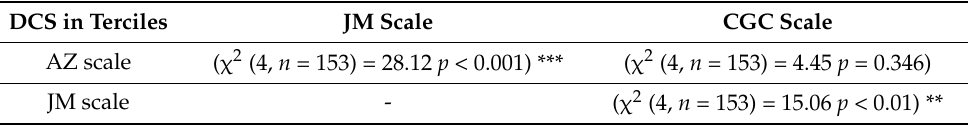
Table 6. Percentage of the sample in the same terciles [chi-square